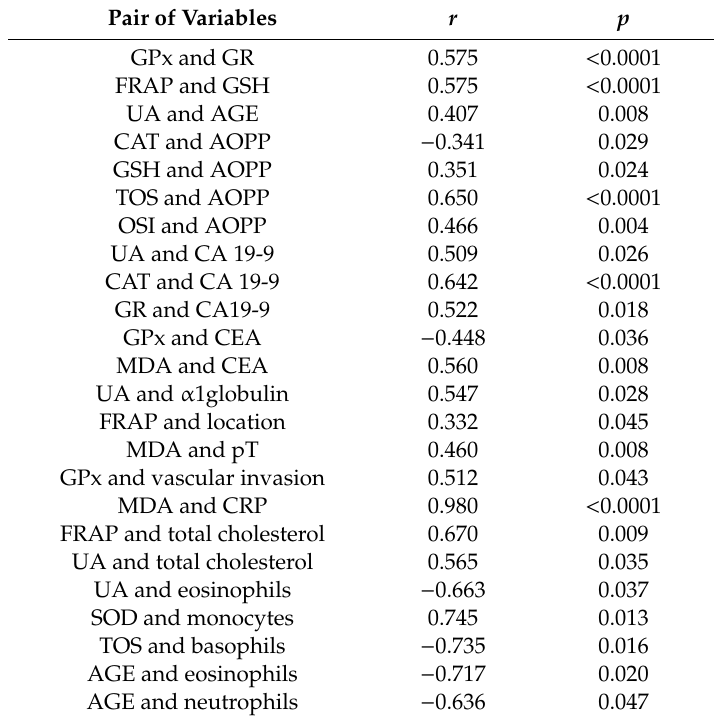
Table 5. Correlations of redox biomarkers in patients with colorectal